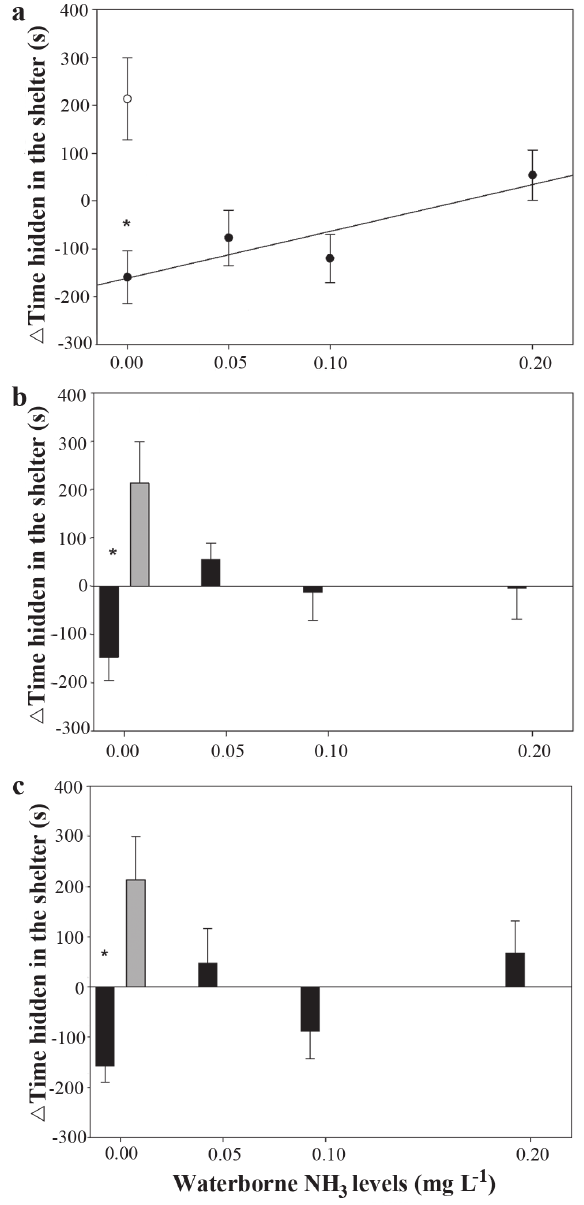
Fig. 1. Change in time spent in the shelter (mean ± SE) before and after exposure to predator odour (black dots or bars) and distilled water (grey bars or empty dots) on days 1 ( a ), 5 ( b ) and 10 ( c ) of exposure to different waterborne NH levels. * 3 indicates a significant difference compared with distilled water (p <0.05). A: y = -161.4 + 972.21x, where y =  time spent in the shelter (s) and x = waterborne NH levels (mg L -1 3